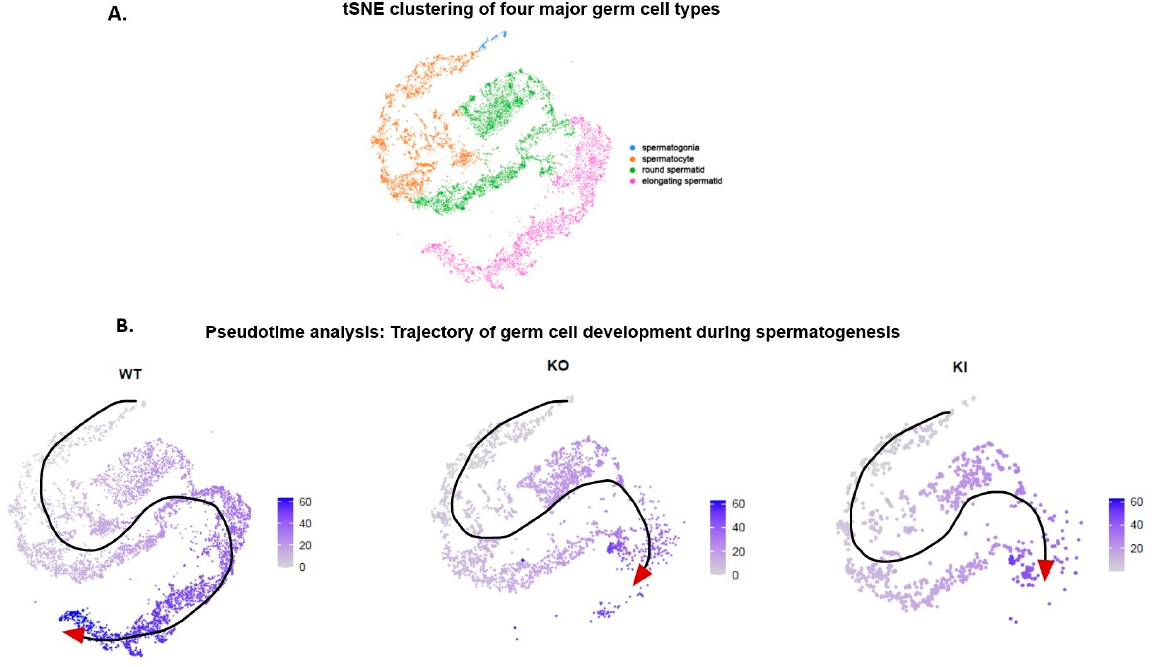
Figure 3. Gene expression dynamics during study state spermatogenesis. ( A ) tSNE plot showing clustering of four major spermatogenic cell types (SG, SP, RS and ES) based on the known marker genes. ( B ) Pseudotime analysis of spermatogenic cell types showing a continuous transition of germ cell development during spermatogenesis process. Trajectory of germ cell development is indicated in arrow.